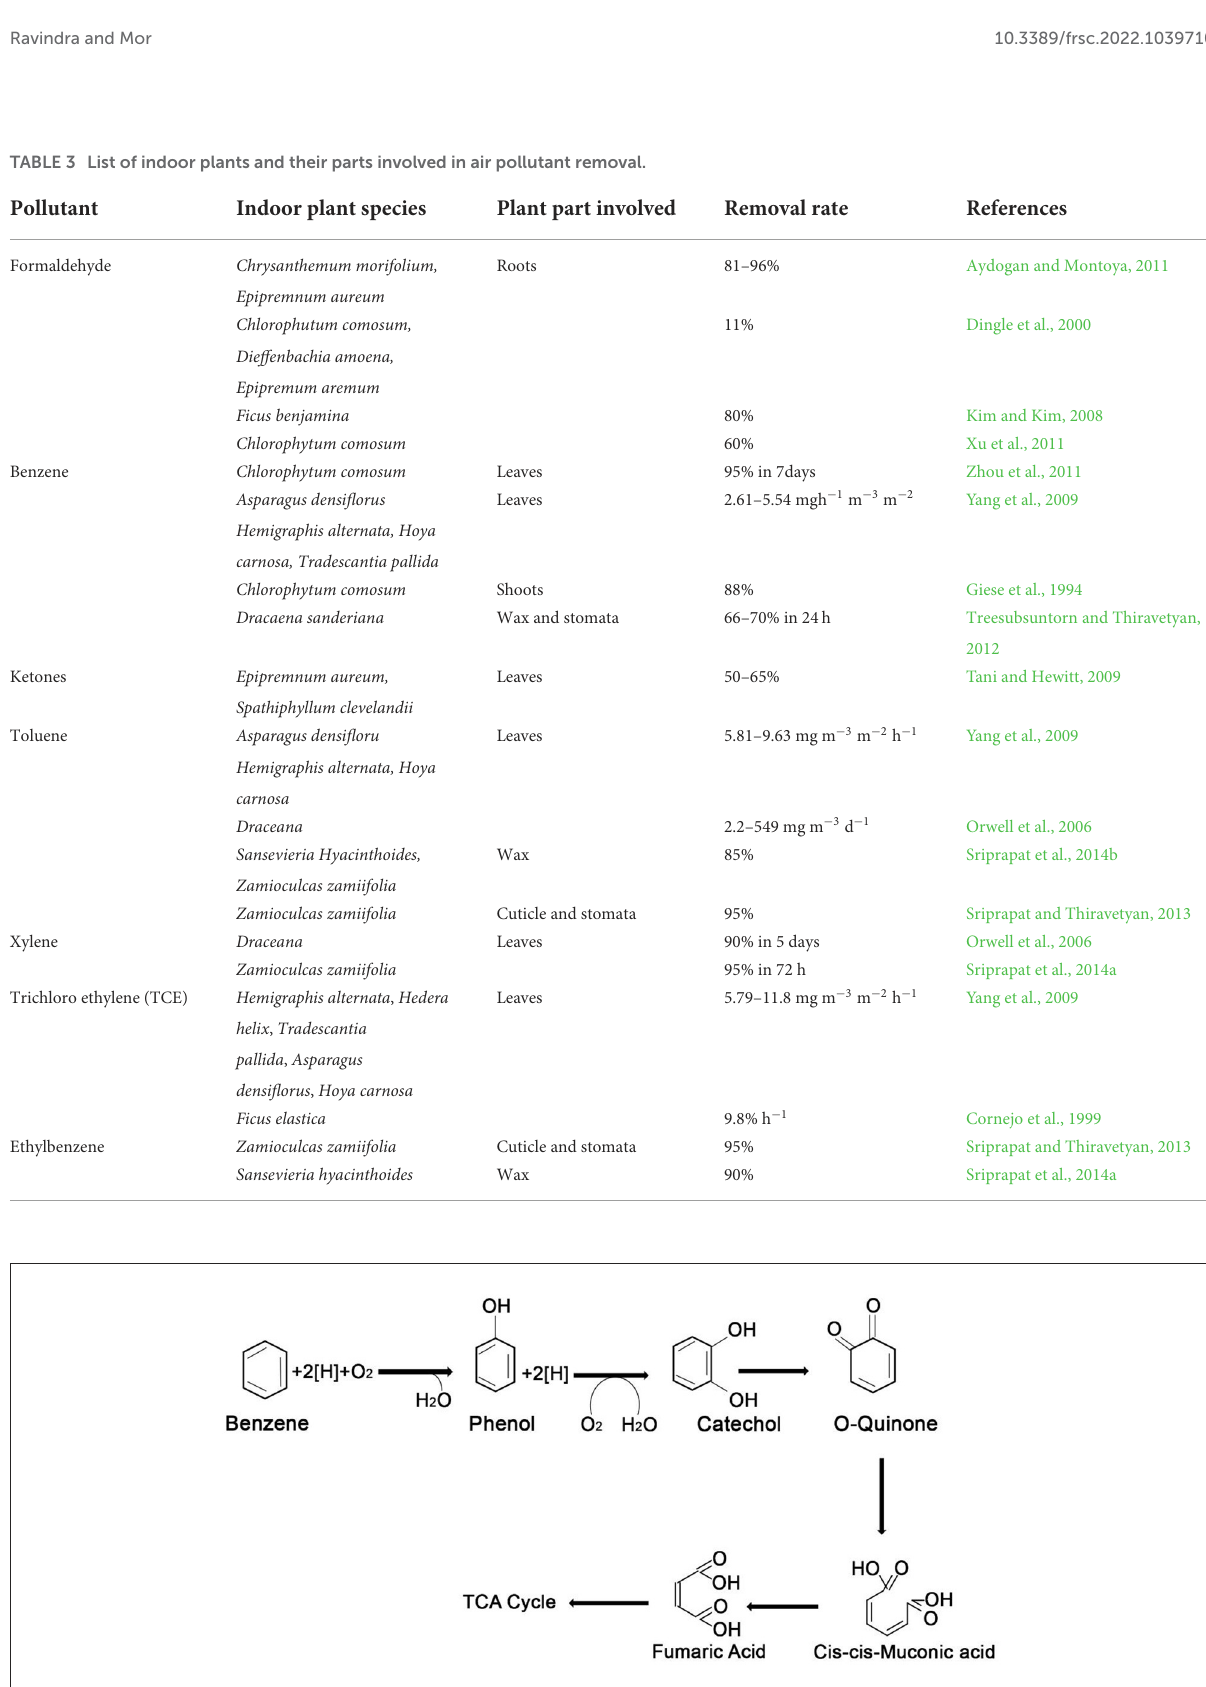
FIGURE7 Pathway of benzene metabolism in